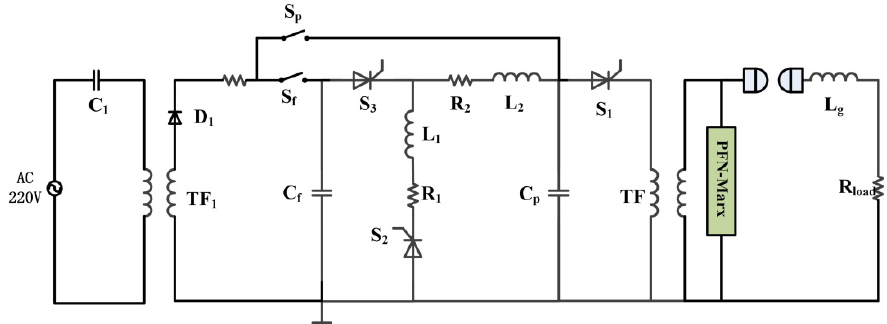
Electronics 2021 , 10 , x FOR PEER REVIEW Figure 8. Schematic circuit of the primary energy subsystem. Figure 8. Schematic circuit of the primary energy subsystem.